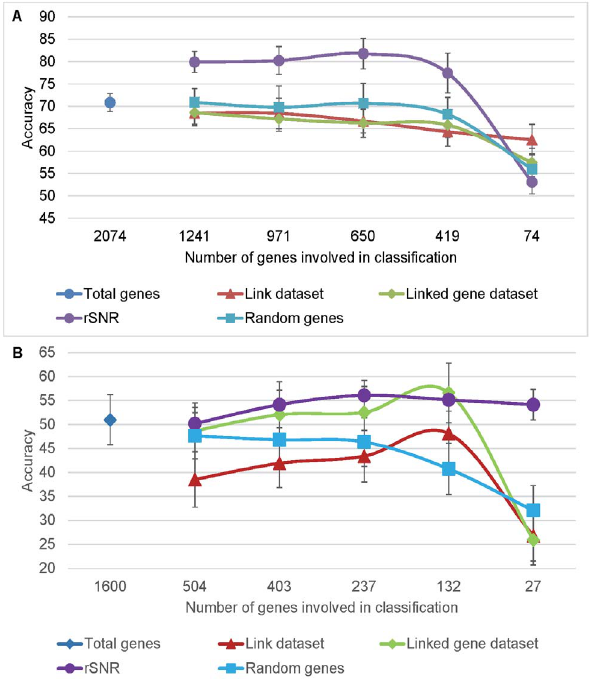
Figure 4. Effect of feature selection methods on the classifica- tion of time-course expression data. Accuracy was calculated based on the A) AtGenExpress and B) EDGE datasets. Error bars indicate 1 standard deviation away from the mean.